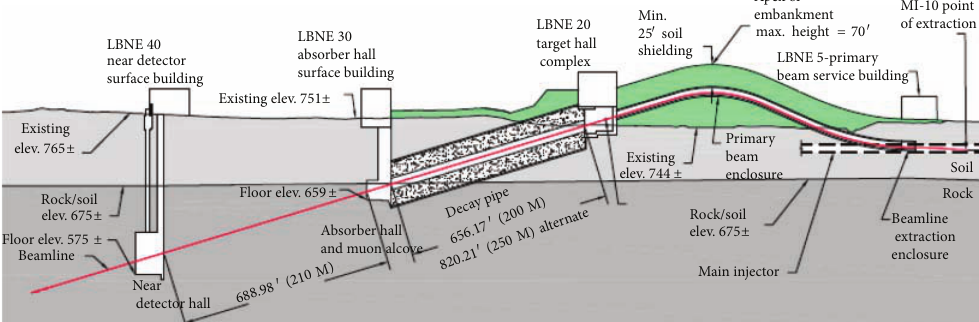
Figure 1: Schematic view of the LBNE beam design located at